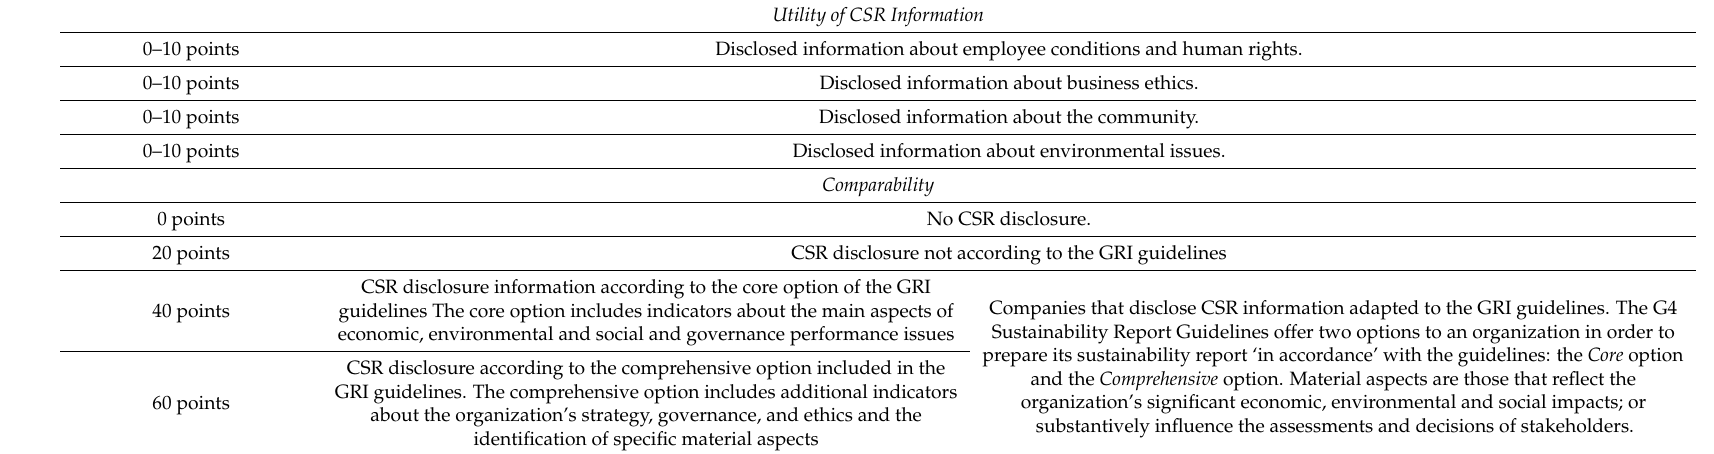
Table 1. Range to measure comparability and